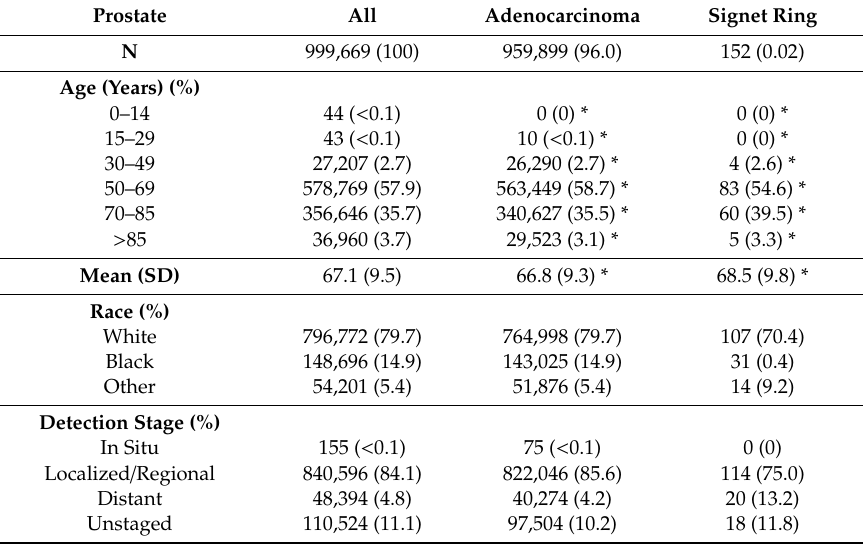
Table 25. Baseline demographics and clinical characteristics by histology for prostate